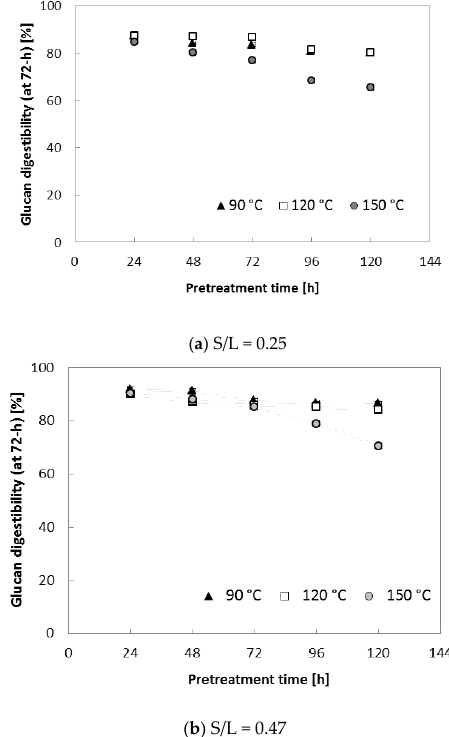
Figure 4. Glucan digestibility at elevated pretreatment temperature. Pretreatment: 0.16 (g NH 3 )/(g biomass), 90–150 °C, 24–120 h, ( a ) S/L ratio = 0.29, ( b ) S/L ratio = 0.47. Enzymatic hydrolysis conditions: 15 (FPU CTec2)/(g glucan) loading, 50 °C, 150 rpm, hydrolysis time: 72 h. The data in the figure show mean values (standard deviation < 1.5).